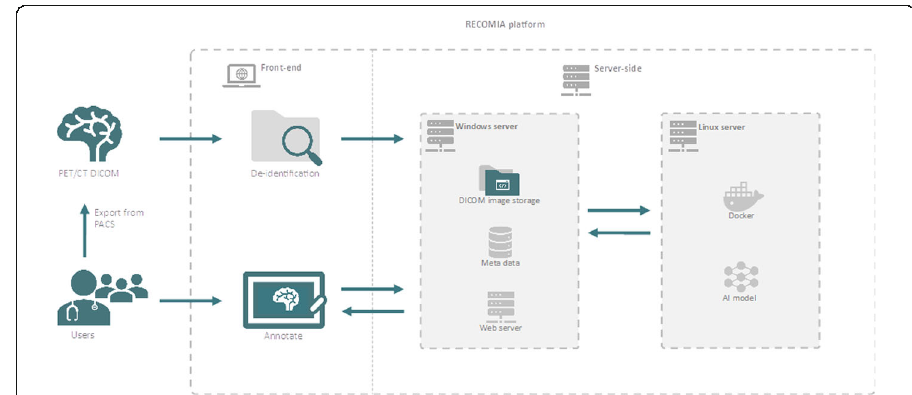
Fig. 1 RECOMIA platform architecture overview and user interaction